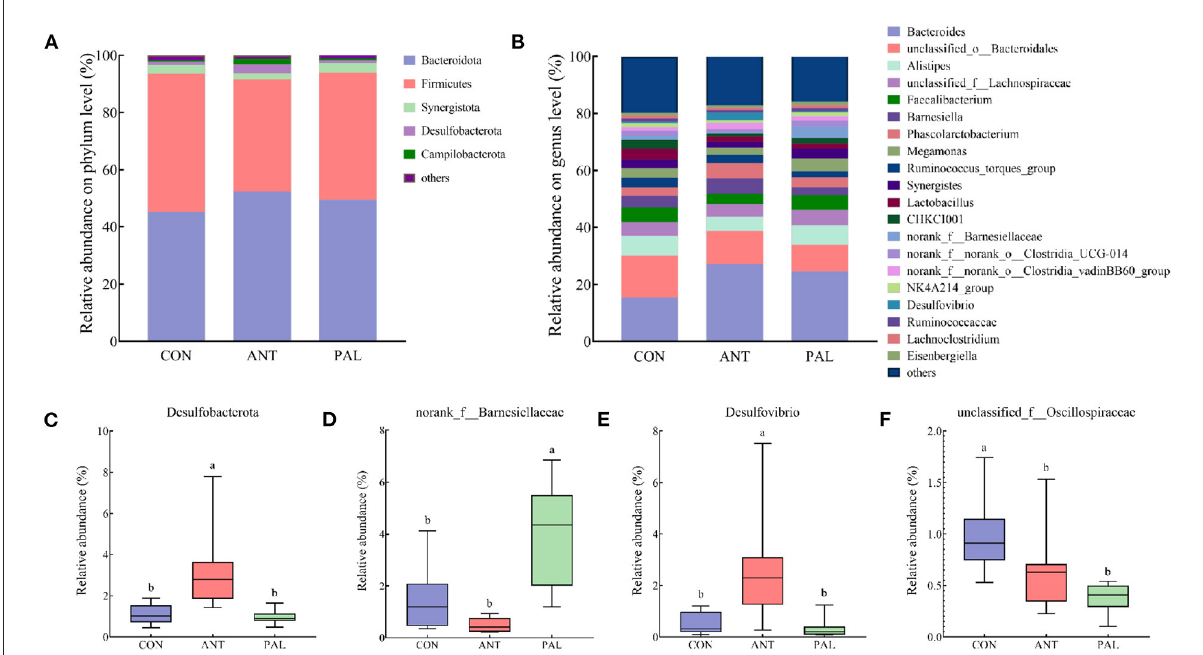
FIGURE2 Effects of dietary palygorskite supplementation on the taxonomic composition and distribution of cecal content in broilers. (A,B) bar plots of microbial composition at phylum (A) and genus (B) levels; (C–F) , significantly differential bacteria taxa at phylum (C) and genus (D–F) levels; a,b, different superscripts indicate significant differences among groups ( P < 0.05); CON, basal diet; ANT, basal diet supplemented with 50 mg/kg chlorotetracycline; PAL, basal diet supplemented with 10 g/kg